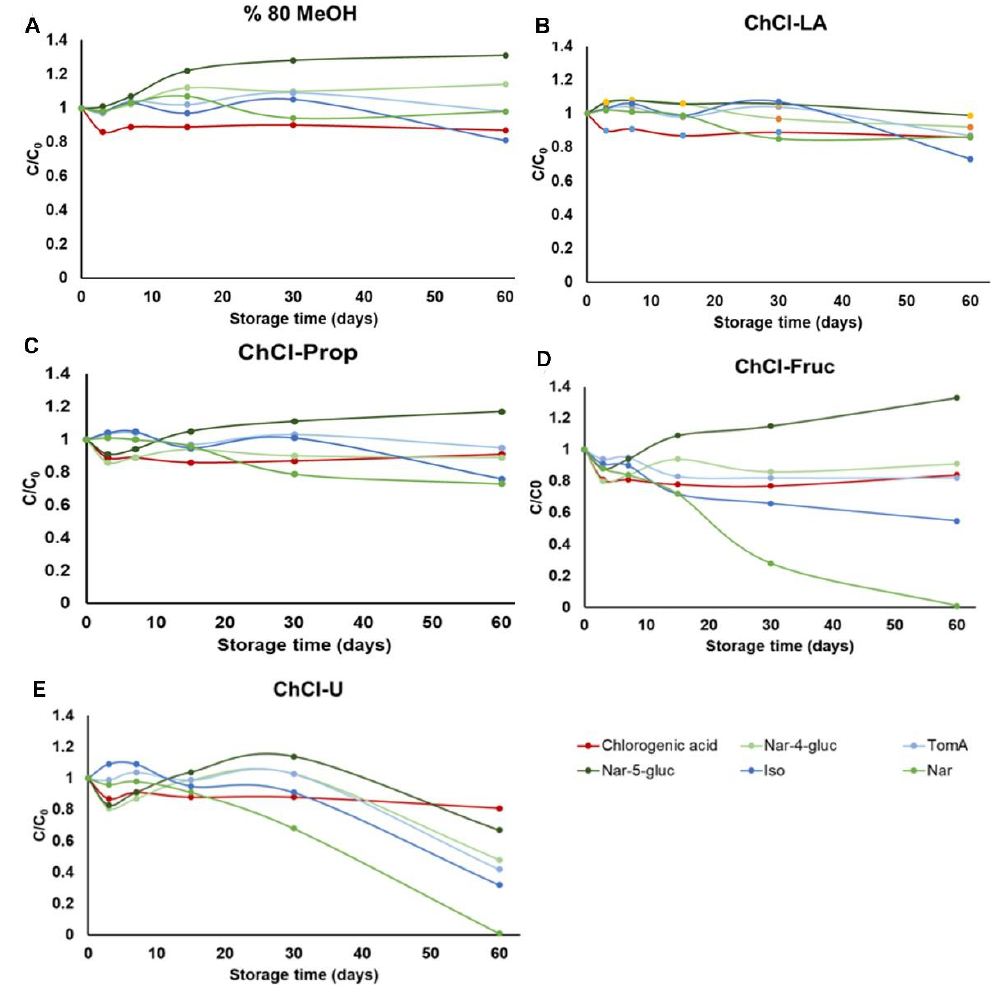
Figure 3. Stability of the selected phenolic compounds extracted from H. arenarium with five different solvents ( A ) 80% MeOH, ( B ) choline chloride-lactic acid (1:2) NADES, ( C ) choline chloride:1,2-propanediol (1:2) NADES, ( D ) choline chloride:fructose:water (2:1:1) NADES and ( E ) choline chloride:urea (1:2) NADES), over a period of 0 to 60 days, stored at -18 °C.